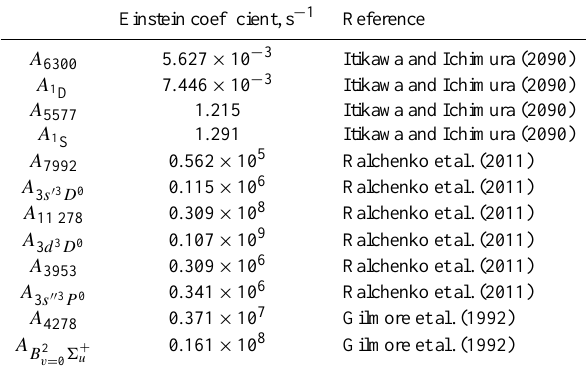
Table 1. Einstein coefficients.